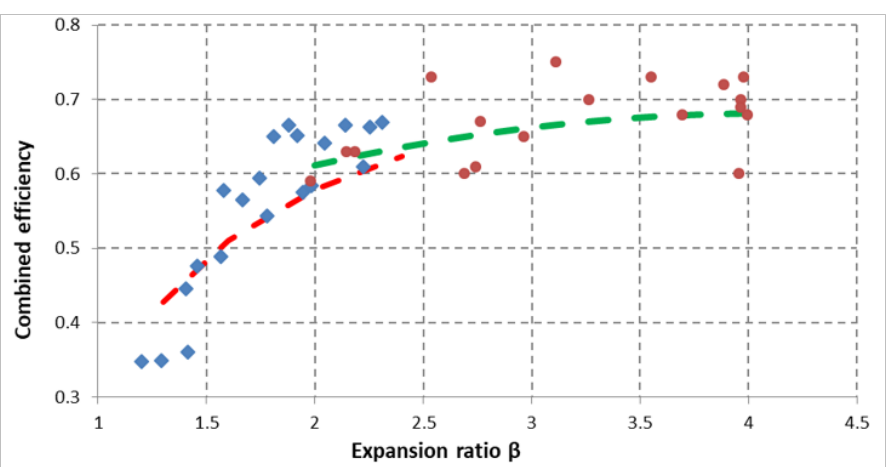
Figure 6. Combined e ffi ciency η T m as a function of expansion ratio β. Red dots are the value obtained with Equations (8), (11), (21), and the extrapolation process whereas the green line shows the results obtained in [38] for the same values of β